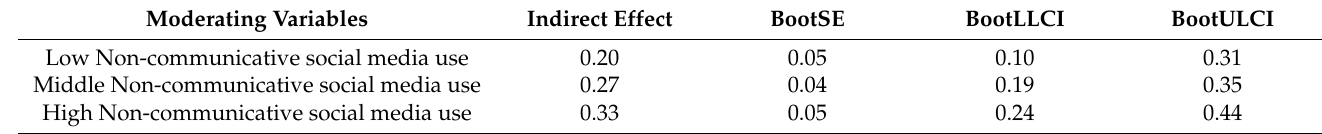
Table 6. Analysis of moderating mediating (moderating variable = communicative social media